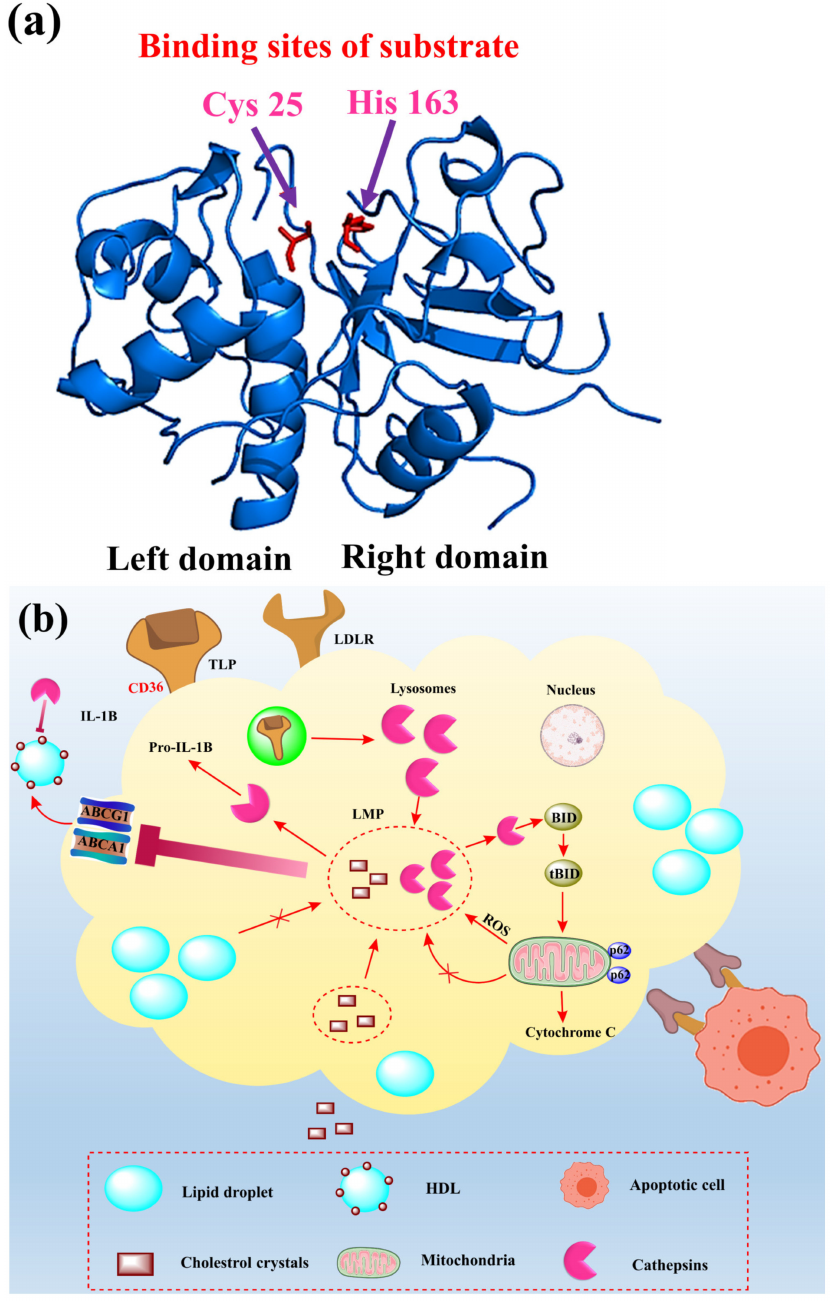
Figure 5. The representative structure of (a ) fold of mature cathepsin L and ( b ) role of cathepsins in regulating inflammation in atherosclerosis. Cathepsins are involved in the regulation of inflammation in atherosclerosis by clearing the apoptotic cell [187]. Cathepsin function in atherosclerosis is cat- alyzed by suppressing the oily foam formation that leads to atherosclerosis in arteries due to excess cholesterol that increases the chances of reactive oxygen species and hence strong activity by clearance of the apoptotic cell. Cathepsins move into the cytosol by promoting apoptosis by degrading excess high-density lipoproteins (HDL) by processing the IL-1 β [188,189]. Lysosomes bind to Low-density lipoprotein receptors (LDLR), causing them to degrade fatty acids and lipids through acid hydrolases. Impairment in cathepsin’s catalytic functioning leads to the deposition of excess cholesterol that causes stress and free radicals due to reactive oxygen species [185]. tBID: Truncated BID, LMP: Lyso- somal membrane permeabilization, TLR: Toll-like receptor, ABCA1: ATP-binding cassette transporter, figure is reproduced from Weiss-Sadan et al. [185] (Attribution 4.0 International, CC BY